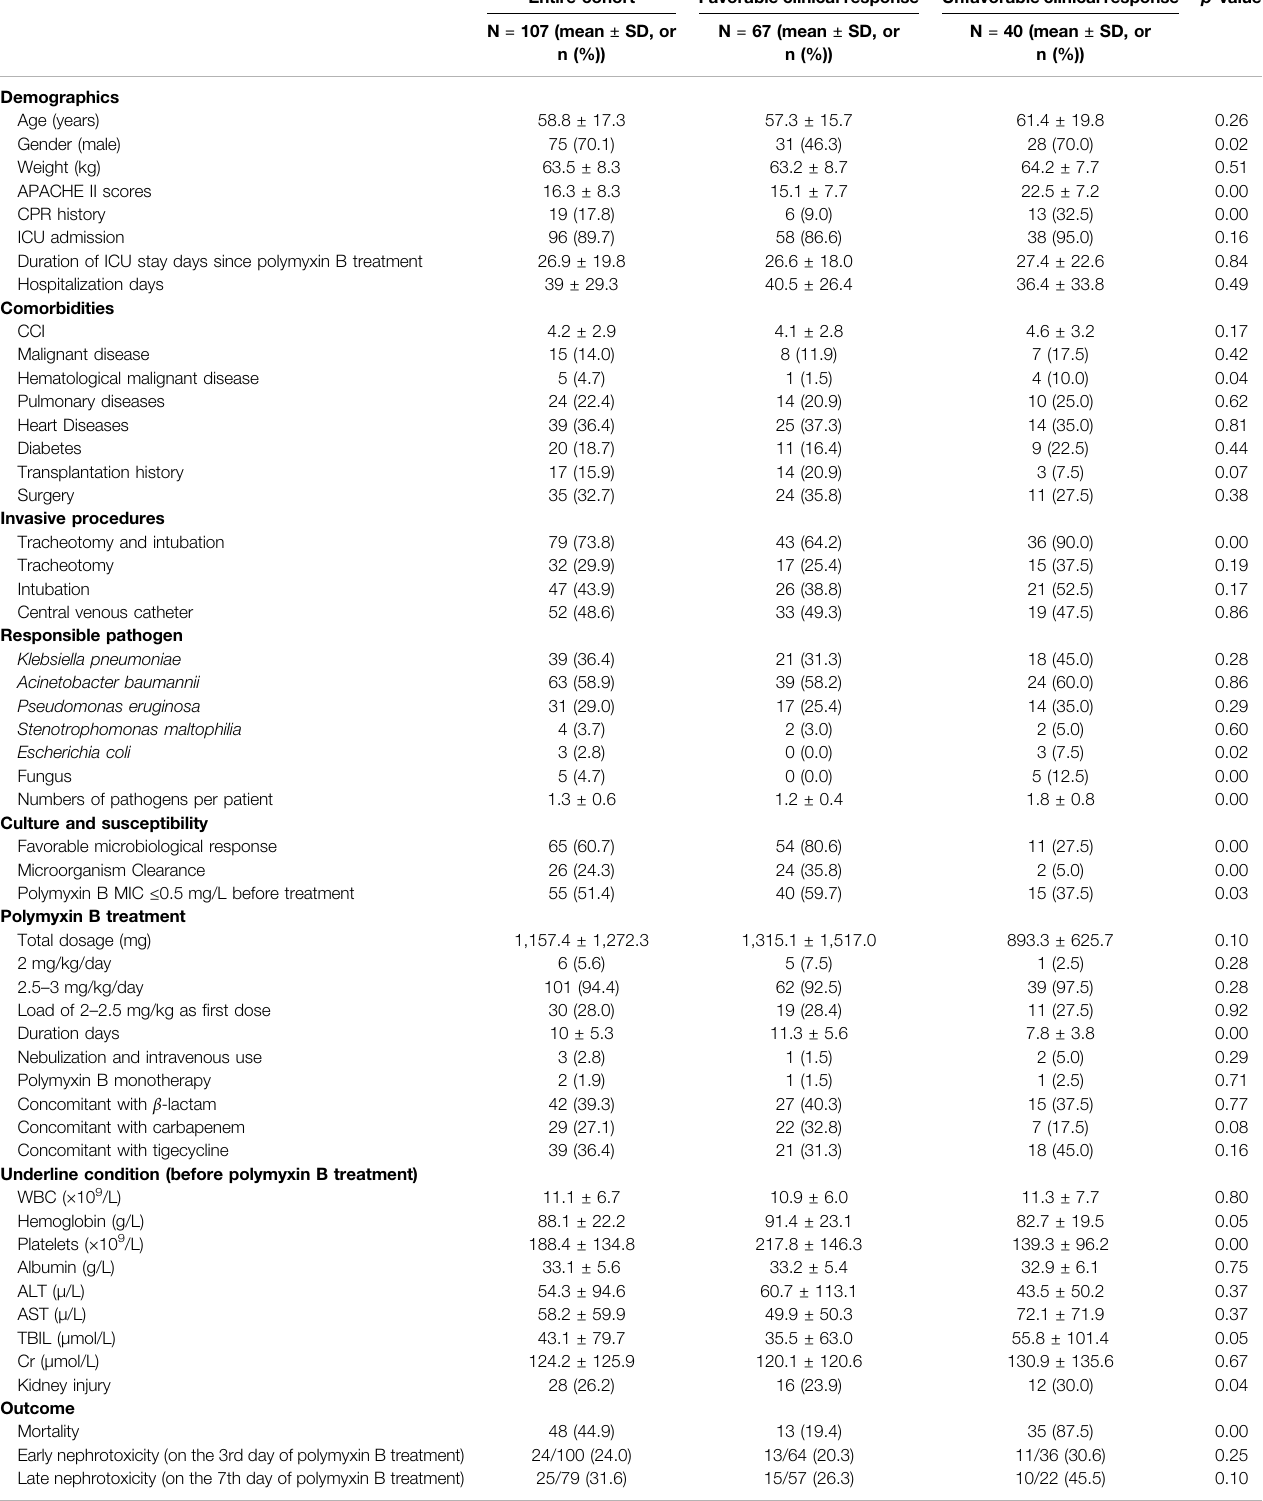
TABLE 1 | Characteristics of cohorts and univariate analysis for clinical response to